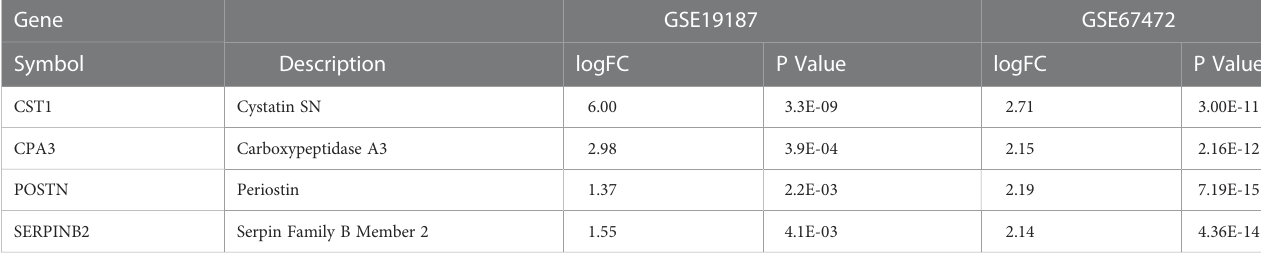
TABLE 3 Differential analysis results of 4 key genes screened by WGCNA network.